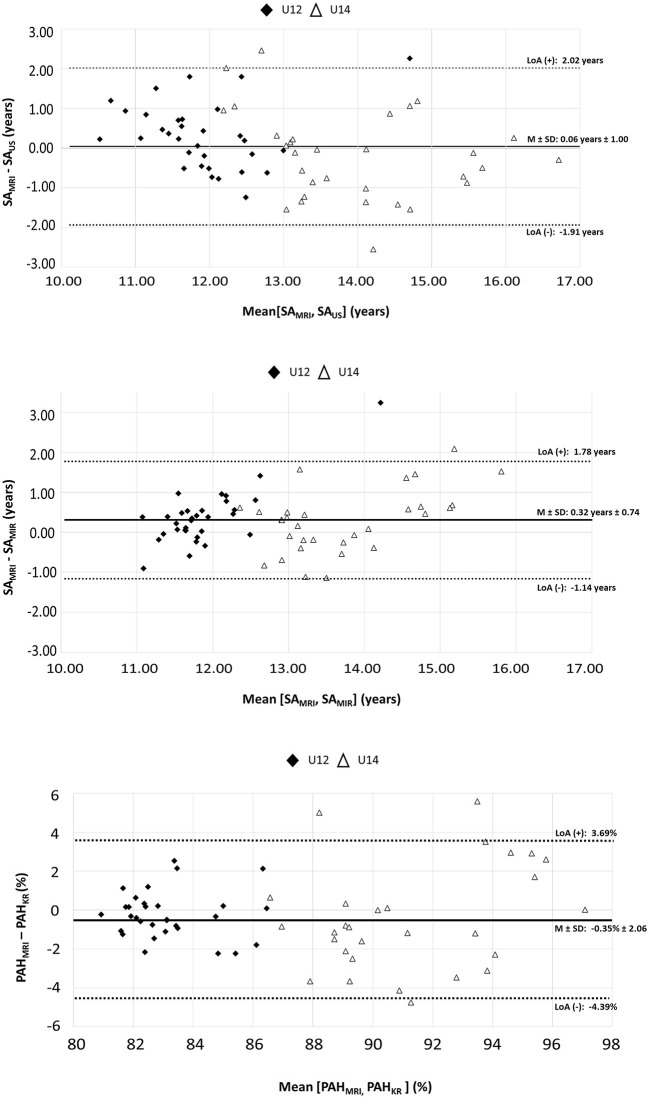
Bland–Altman plots: individual differences of SAMRI and the alternative BMS diagnostics. SAMRI, skeletal age determined by magnetic resonance imaging; SAUS, skeletal age determined by mobile ultrasound device; SAMIR, maturity offset (Mirwald et al., 2002) transformed to skeletal age according to Thodberg et al. (2009); PAHKR, percentage of adult height according to Khamis and Roche (1994); PAHMRI, skeletal age determined by magnetic resonance imaging converted to percentage of adult height according to Thodberg et al. (2009).